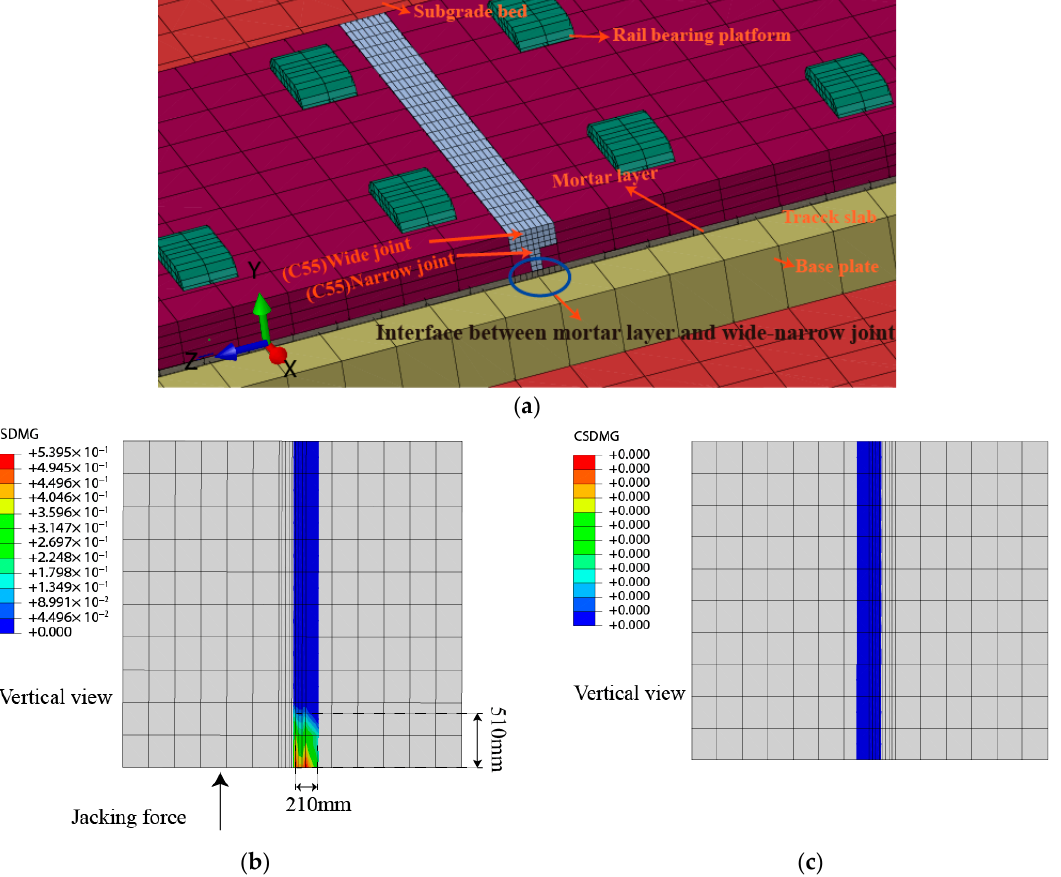
Figure 11. Damage and failure of interface between mortar layer and wide-narrow joint under 500 kN jacking force, ( a ) Schematic diagram of the wide-narrow joint, ( b ) 0 # slab with jack, ( c ) 1# slab with jack (Figure